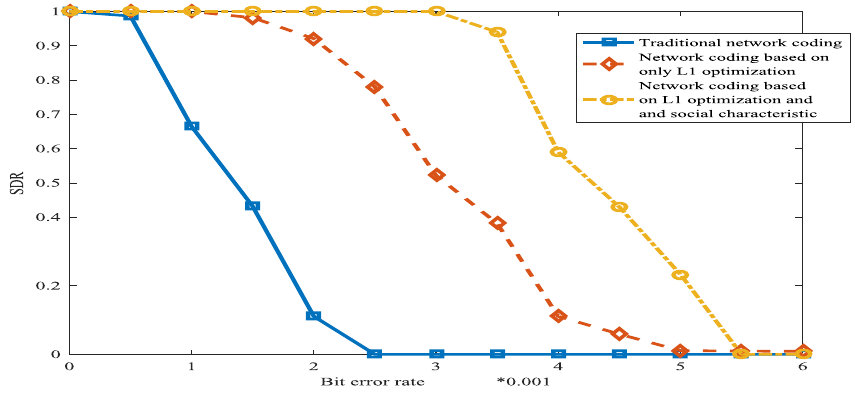
Figure 15. The successful delivered packets based on the bit error rate in WSN.